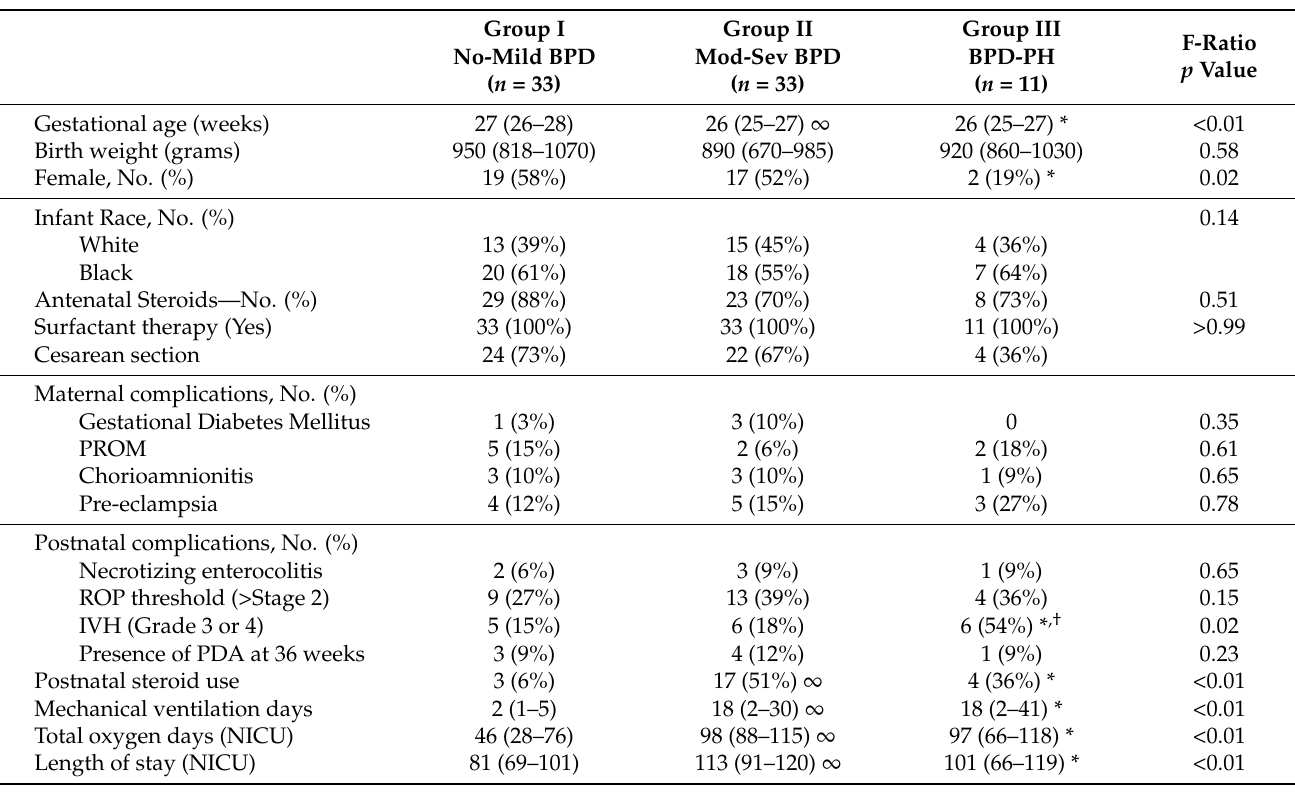
Table 1. Demographics and characteristics of preterm cohorts.